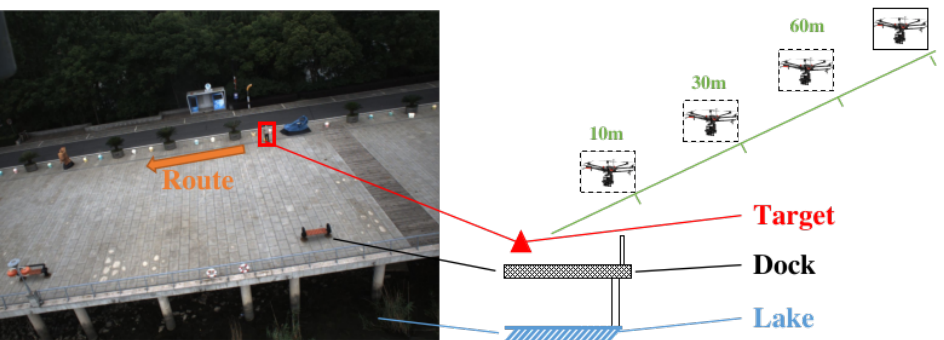
Figure 17. Schematic diagram of the aerial reconnaissance experiment. The image on the left is the actual aerial image (about 30 m apart), the red box is the target’s position, and the image on the right indicates the relative position relationship between the UAV and the target.